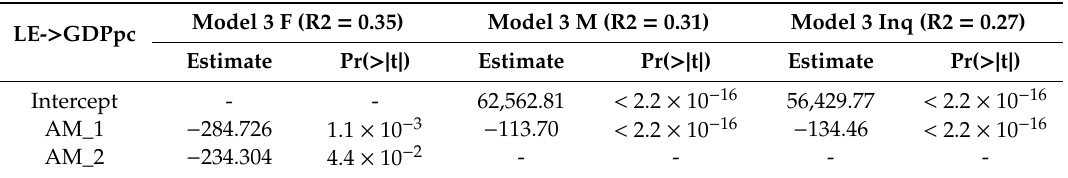
Table 7. Regression analysis output—a multivariate approach to the relations of avoidable mortality and economic prosperity. Model 3 F (R2 =